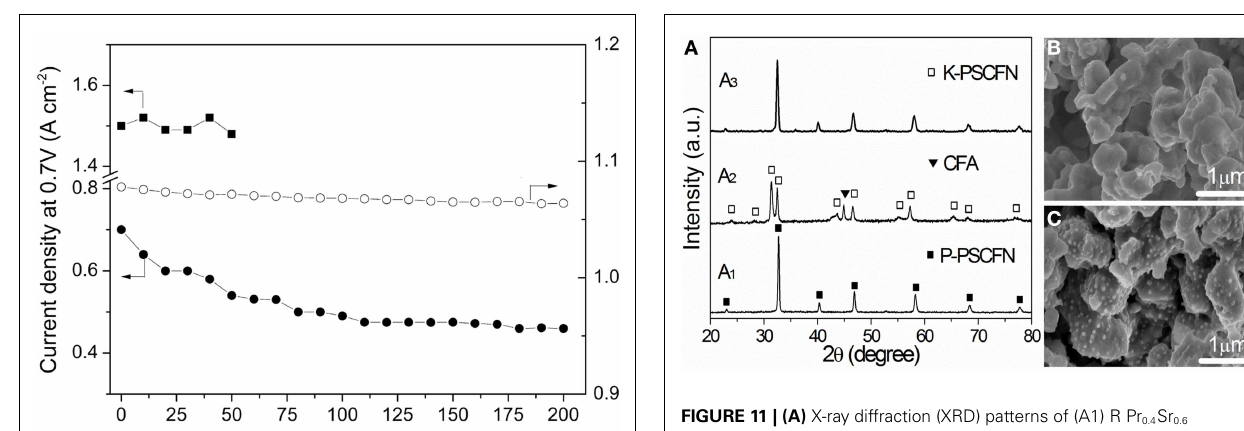
particles ( ≤ 5 nm) formed on La 0.8 Sr 0.2 Cr 0.82 Ru 0.18 O 3 surfaces